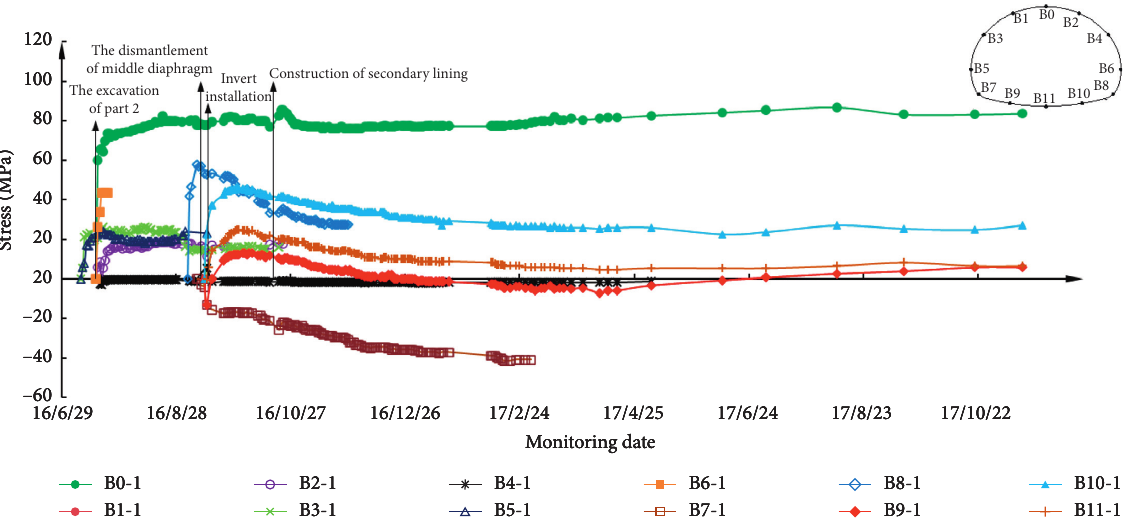
Figure 14: The outside stress curves of steel rib in YK2+133 section.